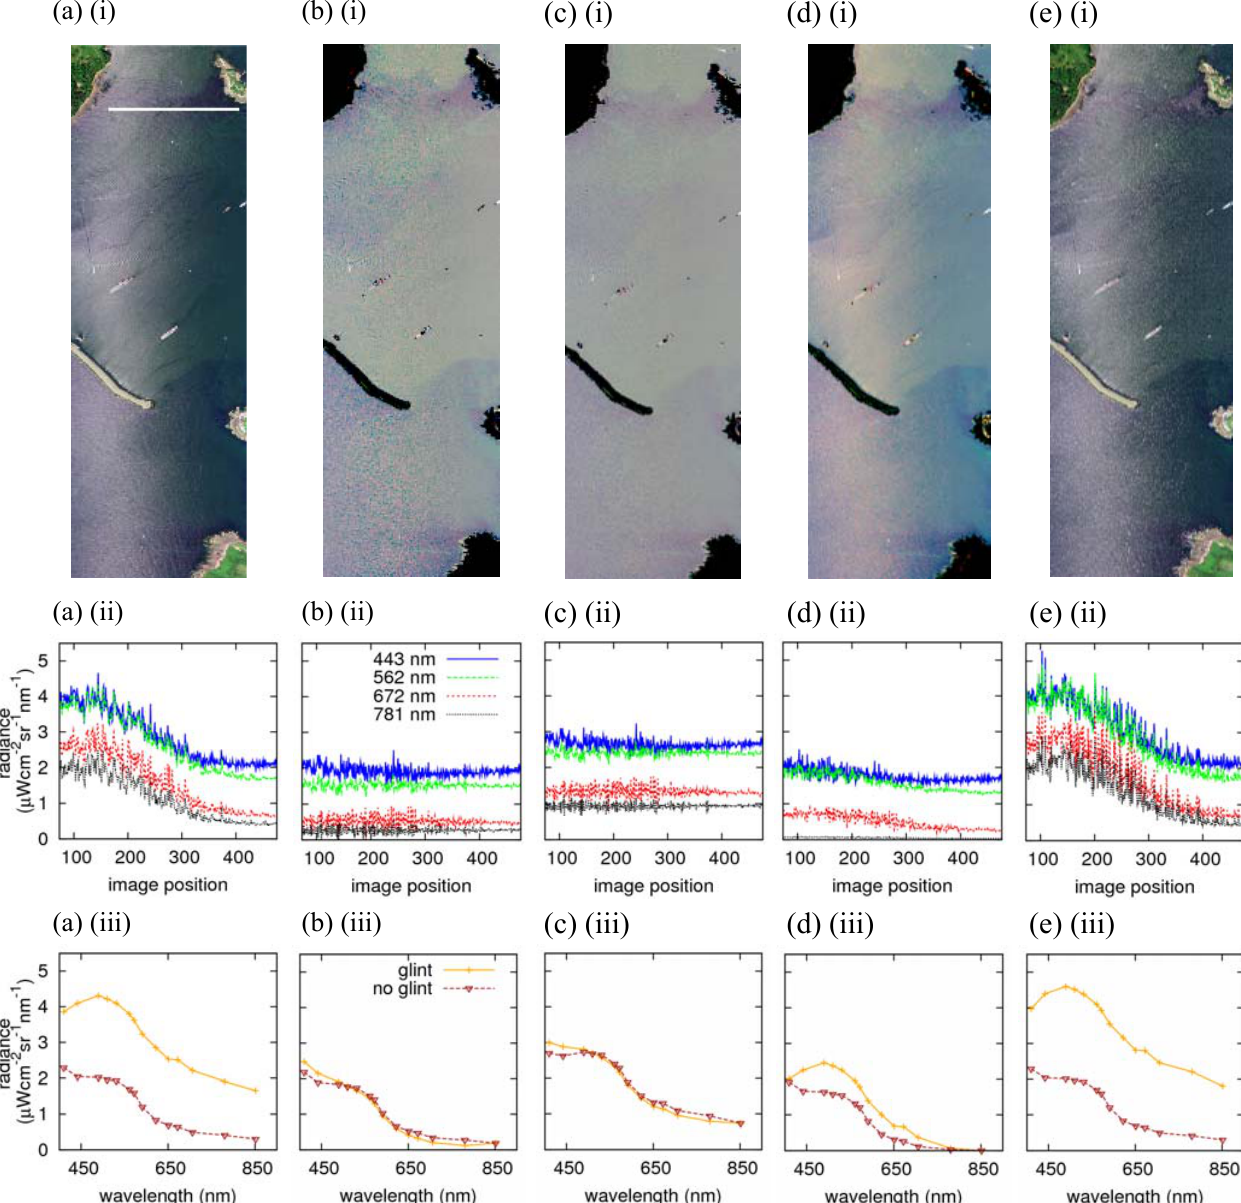
Figure 7. CASI images of Plymouth Sound, UK, showing the effects of different glint correction tools. (a) image with no glint correction, showing regions used in correction and analysis. Image corrected using the method of (b) Hedley et al. (c) Lyzenga et al. (d) Goodman et al. (e) Kutser et al. . In each case (i) is a pseudo-true color representation, (ii) shows four wavebands for pixels along the line shown in (a)(i) and (iii) shows a spectral analysis for pixels at each end of the line (i.e., in the glint and no-glint regions). The wavebands used for the pseudo-true color image are blue 438–447 nm, green 556–566 nm, red 666–677